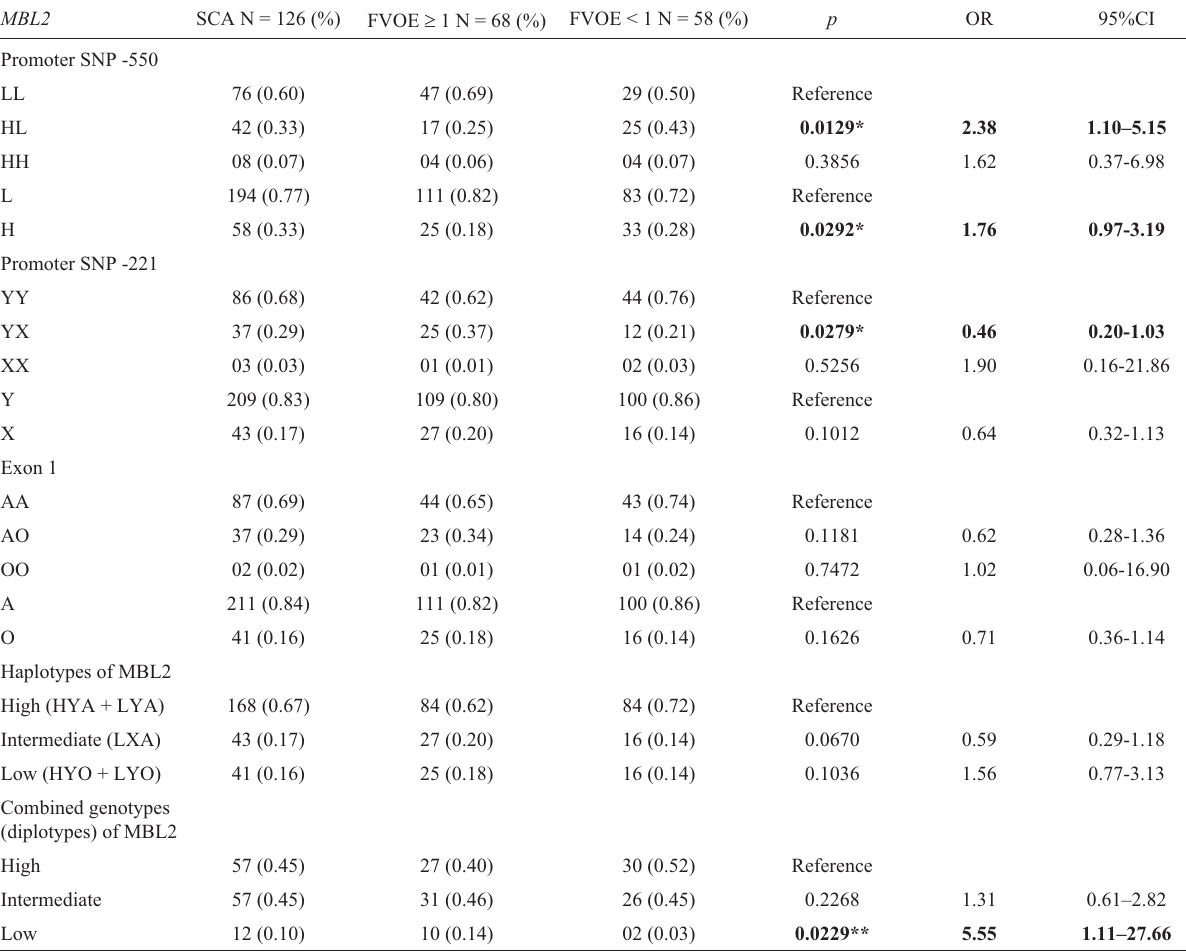
SCA - Sickle cell anemia; FVOE - Frequency of vaso-occlusive events (VOE), defined as the ratio of total episodes divided by the age of the children at the end of this study, adapted according to Mendonça et al. (2010). Patients with < 1 event per year were defined as FVOE < 1/year (mild disease), those with (cid:7) 1eventsperyearweredefinedasFVOE (cid:7) 1/year(severegroup).Combinedgenotypesof MBL2 :high(HYA/HYA,HYA/LYA,LYA/LYA),inter- mediate(HYA/HYO,HYA/LXA,HYA/LYO,LYA/LXA,LXA/LXA,LYA/LYO,HYO/LYA)andlow(HYO/LXA,LXA/LYO,LYO/LYO)MBLlev- els.A–wildallele,O–variantallele,LandY–wild-typealleles,HandX–variantalleles,SNP–singlenucleotidepolymorphism.Significantresultsare shown in bold, the *Chi-square or **Fisher’s exact test were